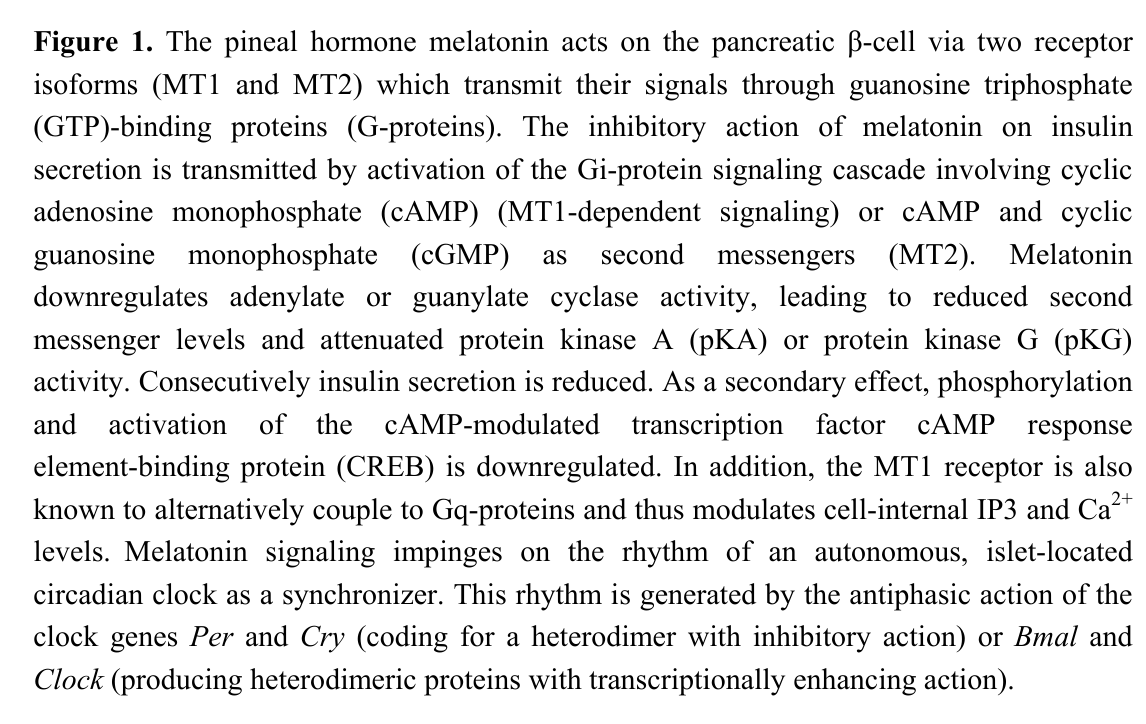
Figure 1. The pineal hormone melatonin acts on the pancreatic β -cell via two receptor isoforms (MT1 and MT2) which transmit their signals through guanosine